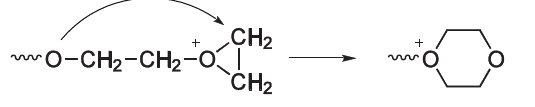
Figure 36. Termination via back-biting; ring expansion.